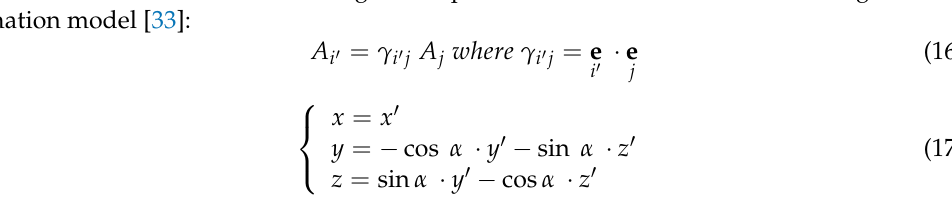
Figure 12. Scheme of transformation system of the Goldak source power distribution [33].